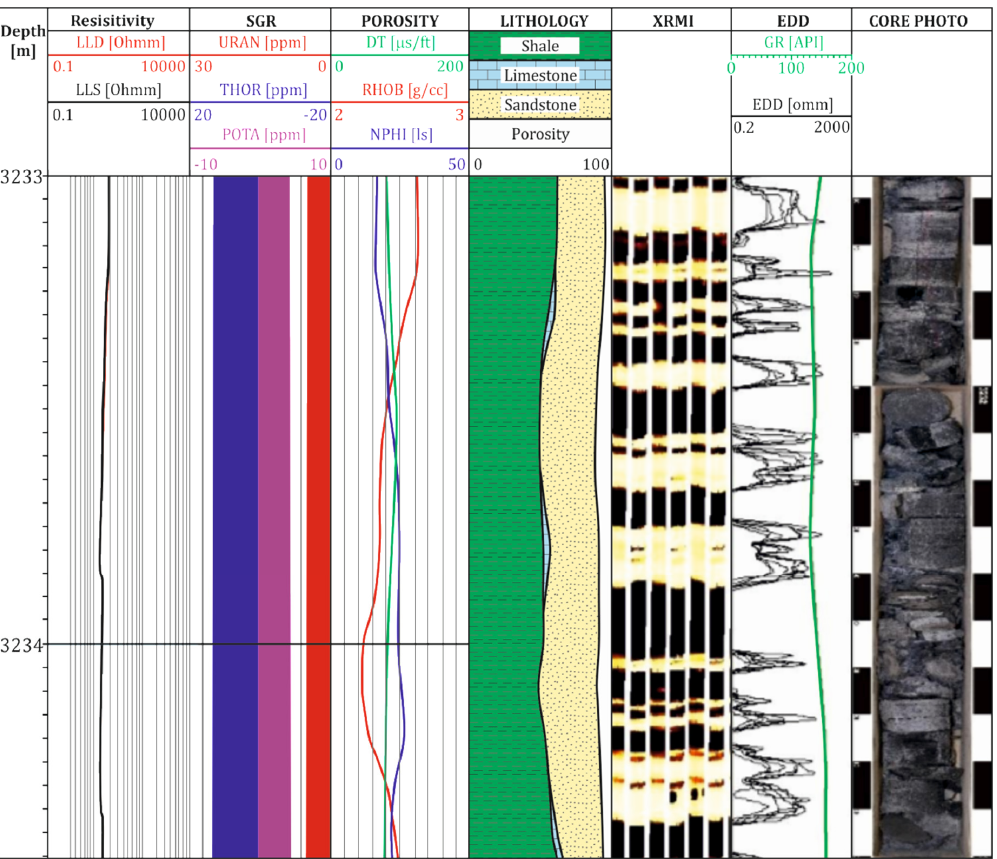
Figure 3. Results of the standard well logging data: electrical resistivity LLD (deep) and LLS (shallow) on track 1; spectral gamma ray logs SGR on track 2; sonic, density, neutron logs on track 3 (porosity logs); lithology, as a result of the comprehensive interpretation of standard logs on track 4; electric image of the borehole wall on track 5; selected microresistivity curves EDD from the XRMI (X-tended Range Micro Imager) and GR (gamma ray log) on track 6; photos of the cores on track 7; Well-1, depth interval 3233–3234.45 m.